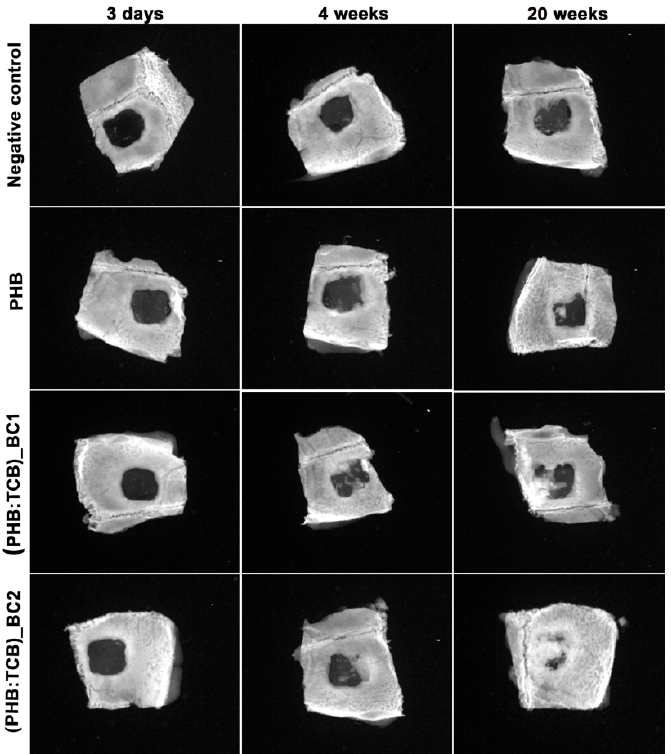
Figure 4. Radiographs of in vivo bone samples treated with scaffolds at different days (3 days, 4 weeks, and 20 weeks). Reprinted with permission [92].